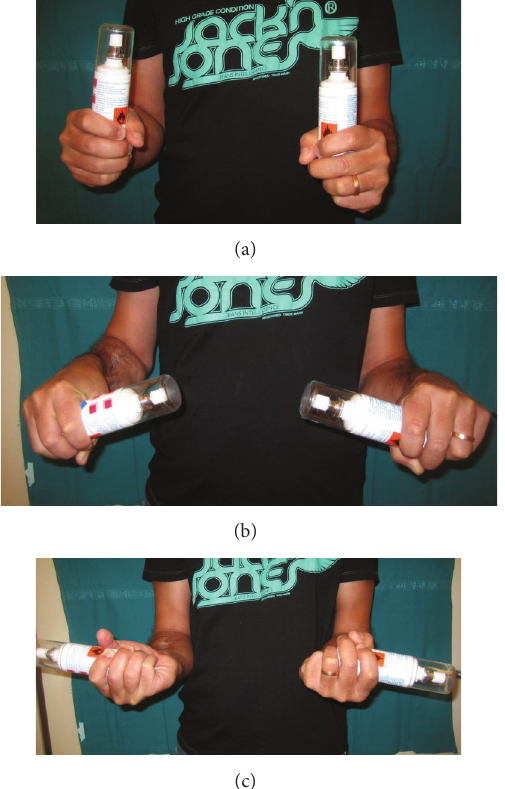
Figure 8: Clinical results at 1 year after excision of the synostosis: complete recovery of ROM in